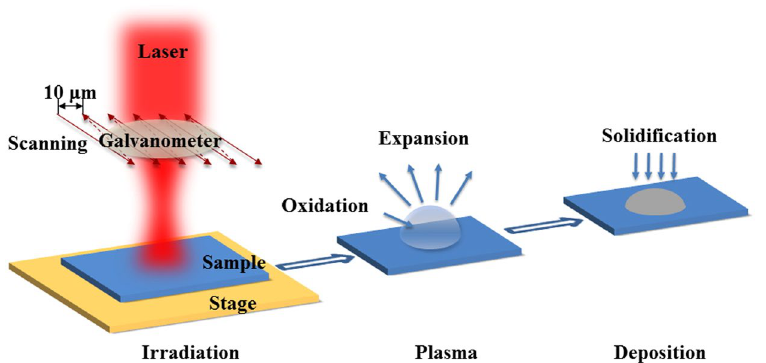
Figure 1. Schematic illustration of the irradiation scanning process of